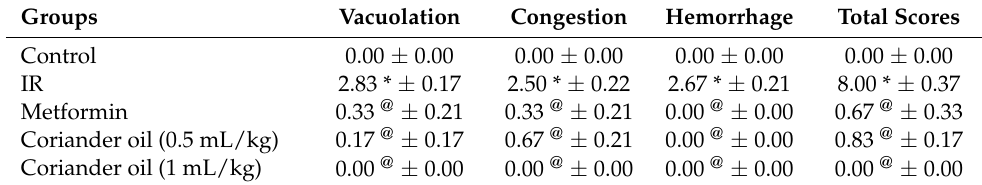
Table 1. Histopathological changes in pancreas of different groups.